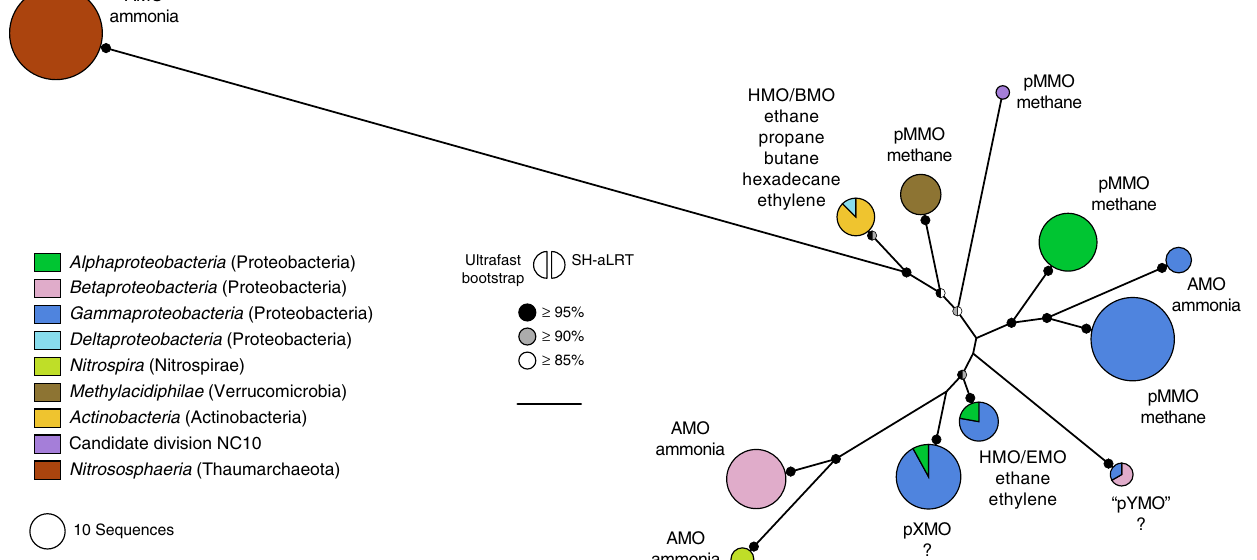
Fig. 10 Phylogenetic placement of the archaeal AMO within the CuMMO superfamily. Phylogeny of the CuMMO superfamily inferred from 125 concatenated subunits A and B (595 aligned codon positions), representing 196 available sequences clustered at 98% protein identity. Clades are collapsed as circles/pie-charts coloured according to taxonomic class (phyla are indicated in brackets); circle diameter is proportional to number of sequences before clustering. Enzyme names and respective substrates known to support growth are indicated next to clades. “ pYMO ” was identi fi ed here and provisionally named as an additional clade of enzymes with unknown substrate, phylogenetically distinct from pXMO 19 . The tree was inferred by maximum likelihood with IQ-TREE 80 using an edge-proportional partition model with codon models SCHN05 + F + Γ 4 and KOSI07 + F + R4 for subunits A and B, respectively. Ultrafast bootstrap 37 and SH-aLRT 38 support values ≥ 85% (1000 replicates) are indicated by semi-circles. The scale bar (below branch support legend) represents 0.5 substitutions per codon